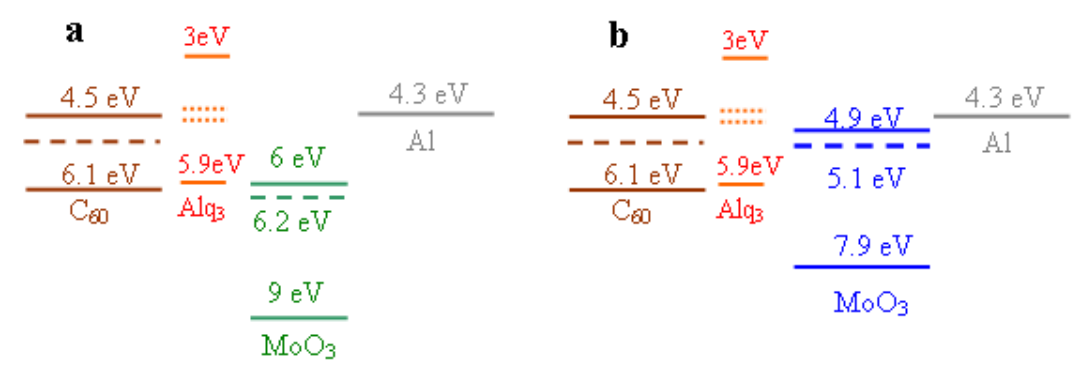
Figure 6. Band scheme of the C ( b ) after five days of air